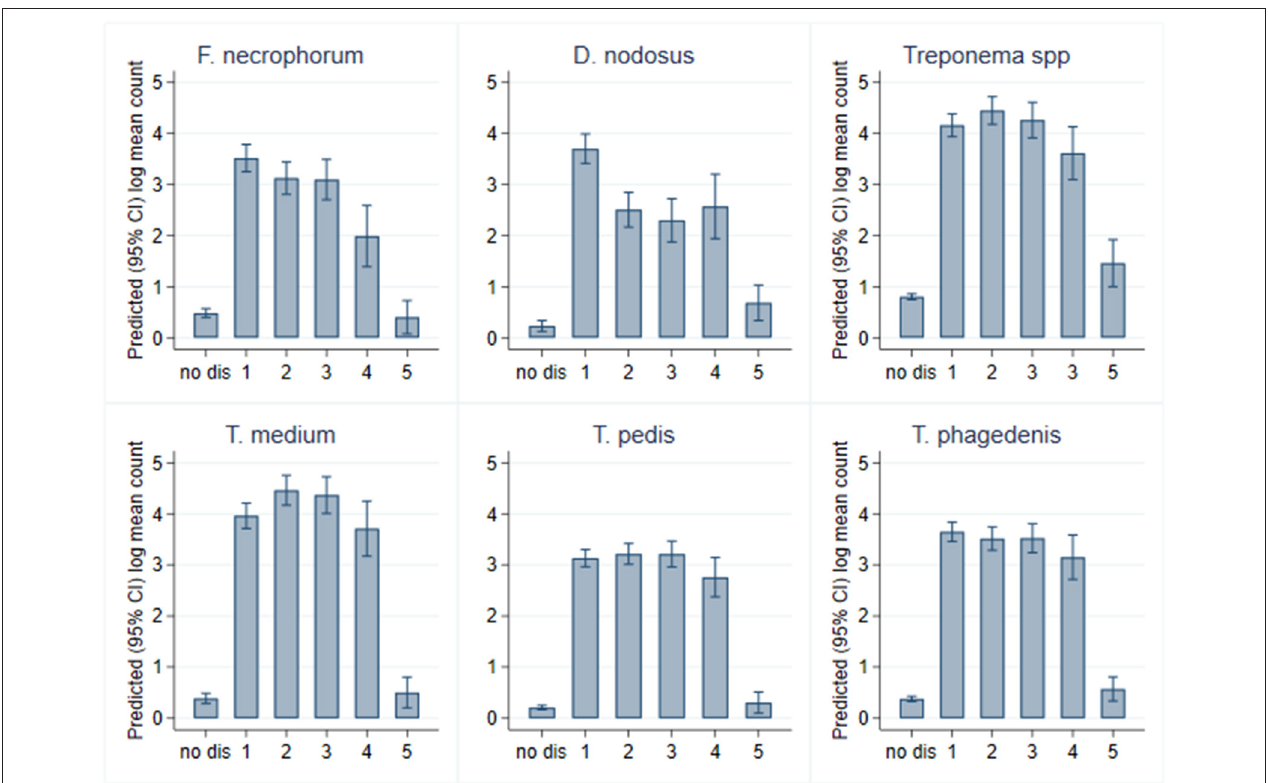
FIGURE 12 | Number of colonized feet and mean log 10 MGCN of CODD feet by pretreatment and 1 and 3 weeks post-treatment ( n = 12 feet).